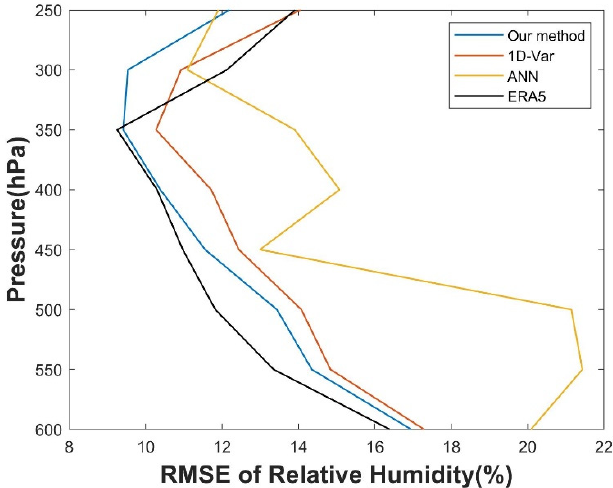
Figure 11. With sounding data from the University of Wyoming as the reference true value, the RMSEs of the three retrieval methods and ERA5 reanalysis data (250–600 hPa).